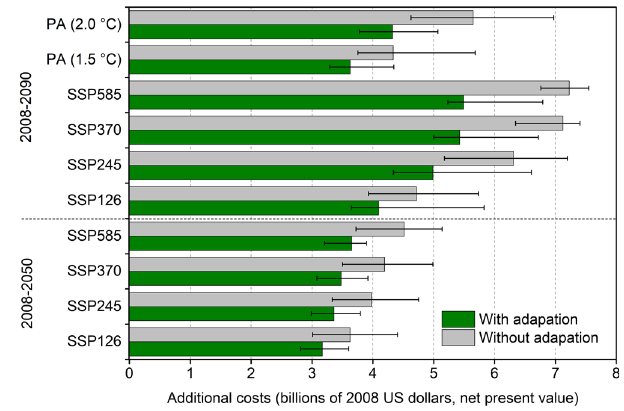
Fig. 3 Additional infrastructure costs from permafrost degradation under different scenarios. Cumulative additional costs during reference period and projected periods, net present value in 2008 billions of US dollars, 2.85% discount rate. The uncertainty ranges were based on the ranges of the mean annual ground temperature and active layer thickness predictions, quanti fi ed by using the 97.5th and 2.5th percentiles of the ensemble predicted mean annual ground temperature and active layer thickness with 200